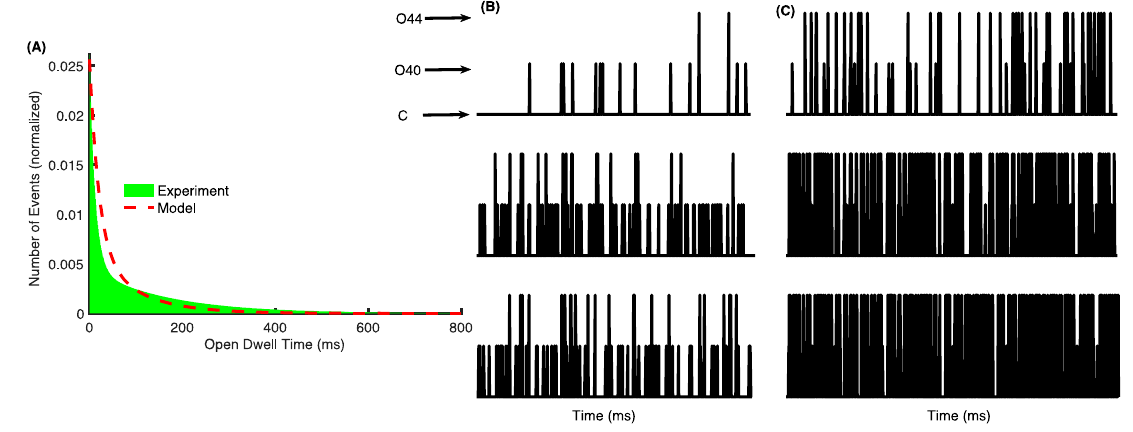
Figure 6. Extracting single channel kinetic parameters by fitting to the open dwell-time distribution. ( A ) Open dwell-time distribution generated using the time constants ( τ 1 = 12.06 ms and τ 2 = 161.92 ms) observed in lipid bilayer experiments [11] (green bars) and model fit (dashed line); ( B ) time traces from the model using the transition rates obtained from the model at [Ca 2 + ] M = 0.4 µ M and [Ca 2 + ] C = 1 µ M (top panel), 10 µ M (middle panel), and 100 µ M (bottom panel); ( C ) same as in ( B ) but at [Ca 2 + ] M = 1 µ M.